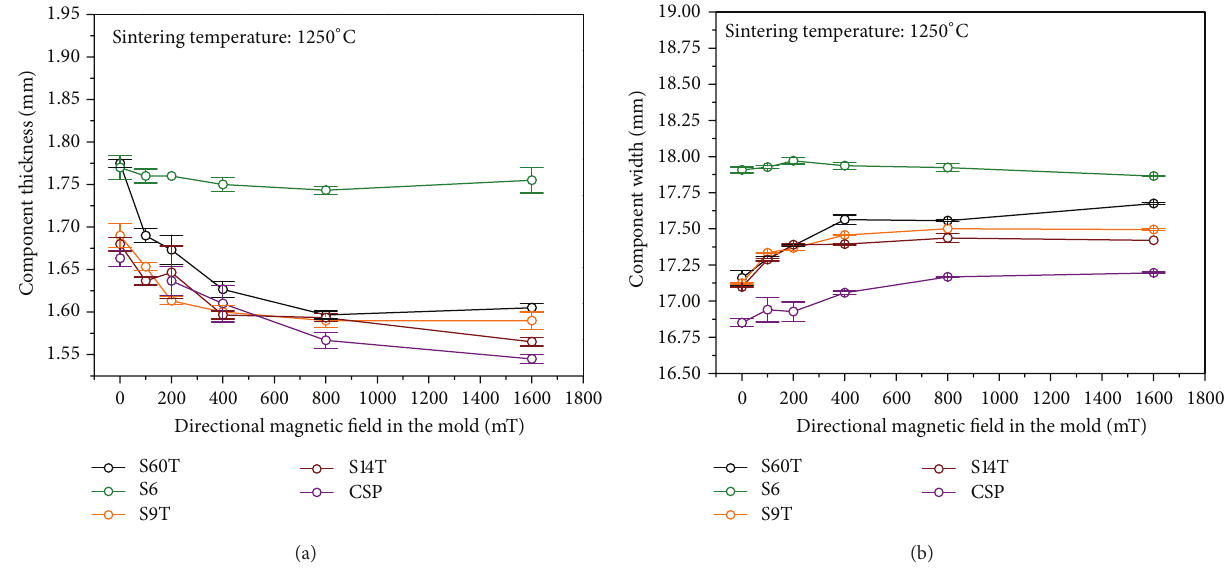
Figure 8: Sizes of sintered devices as a function of the directional magnetic field in the mold.